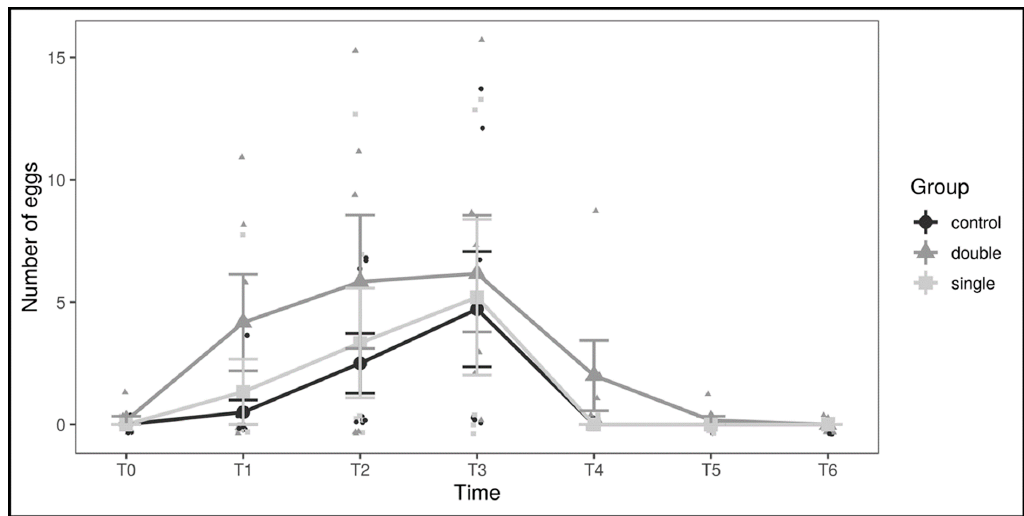
Figure 3. Number of oviductal eggs by experimental group and across timepoints. Large dots represent means by group and timepoint, and vertical bars represent standard errors. Table 1. Mean, standard deviation (SD), and median values for total numbers of follicles (stages II to IV) and for stages II